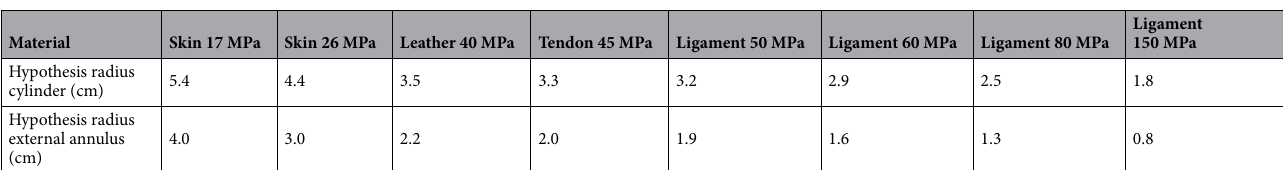
Table 1. The thickness in cm of the different materials needed to sustain the speed of sound (340 m/s) in two of the hypothesized conditions: considering a cylinder of material and the annulus external to the vertebra.